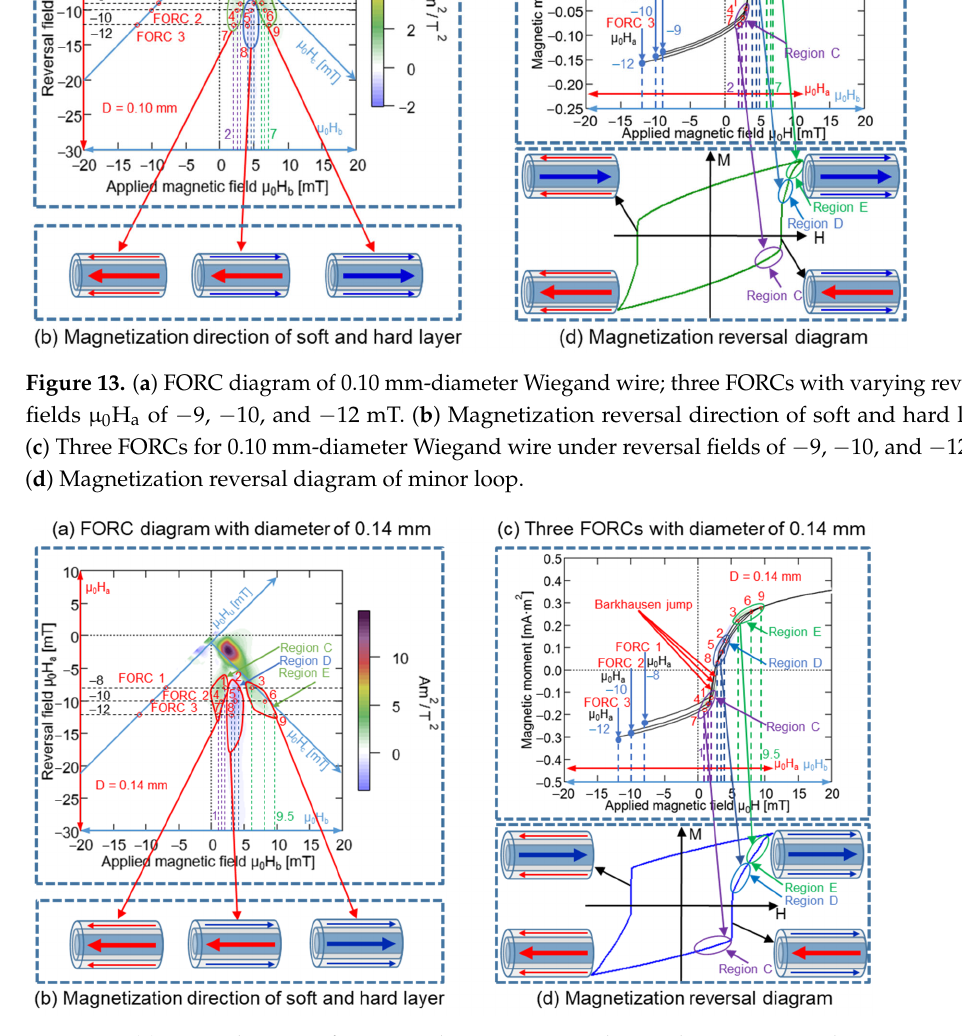
Figure 15. ( a ) FORC diagram for 0.18 mm-diameter Wiegand wire; three FORCs for varying reversal fields μ 0 H a of − 8, − 10, and − 12 mT. ( b ) Magnetization reversal direction of soft and hard layer. ( c ) Three FORCs for 0.18 mm-diameter Wiegand wire for reversal fields of − 8, − 10, and − 12 mT. ( d ) Magnetization reversal diagram of minor loop.